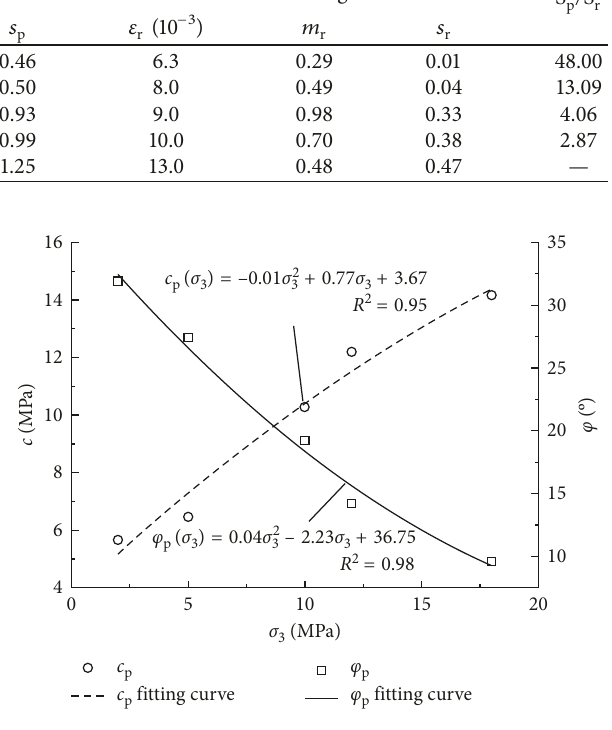
Figure 7: Relationship of c or φ changing with confining